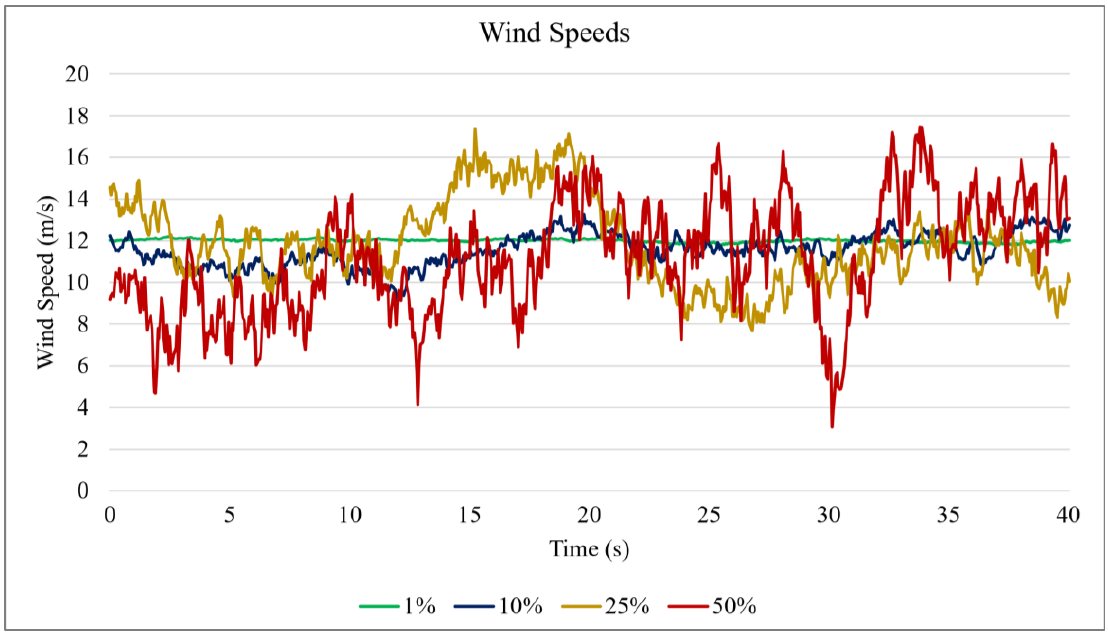
Figure 2. Wind Speeds at Hub